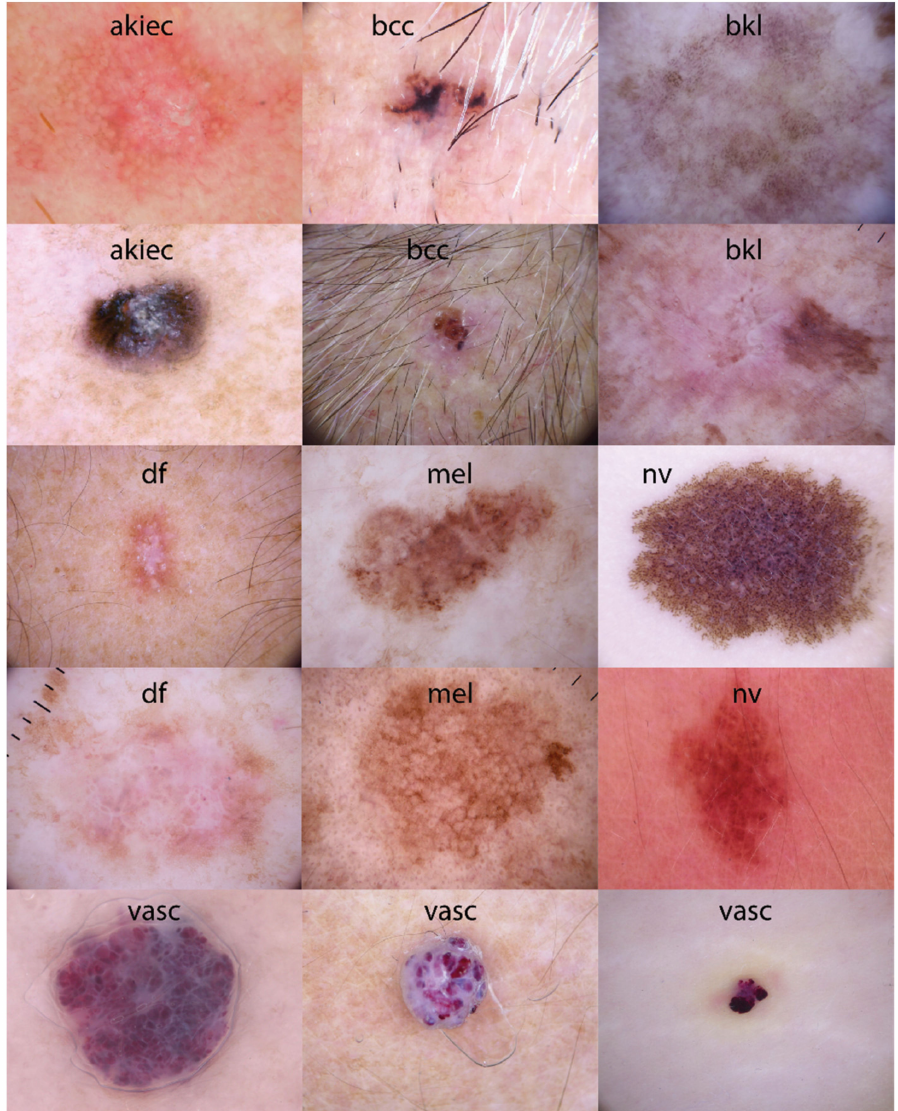
Figure 3. Examples of images in the HAM10000 [21] test set and their corresponding labels. Table 2 shows class names and number of samples in the